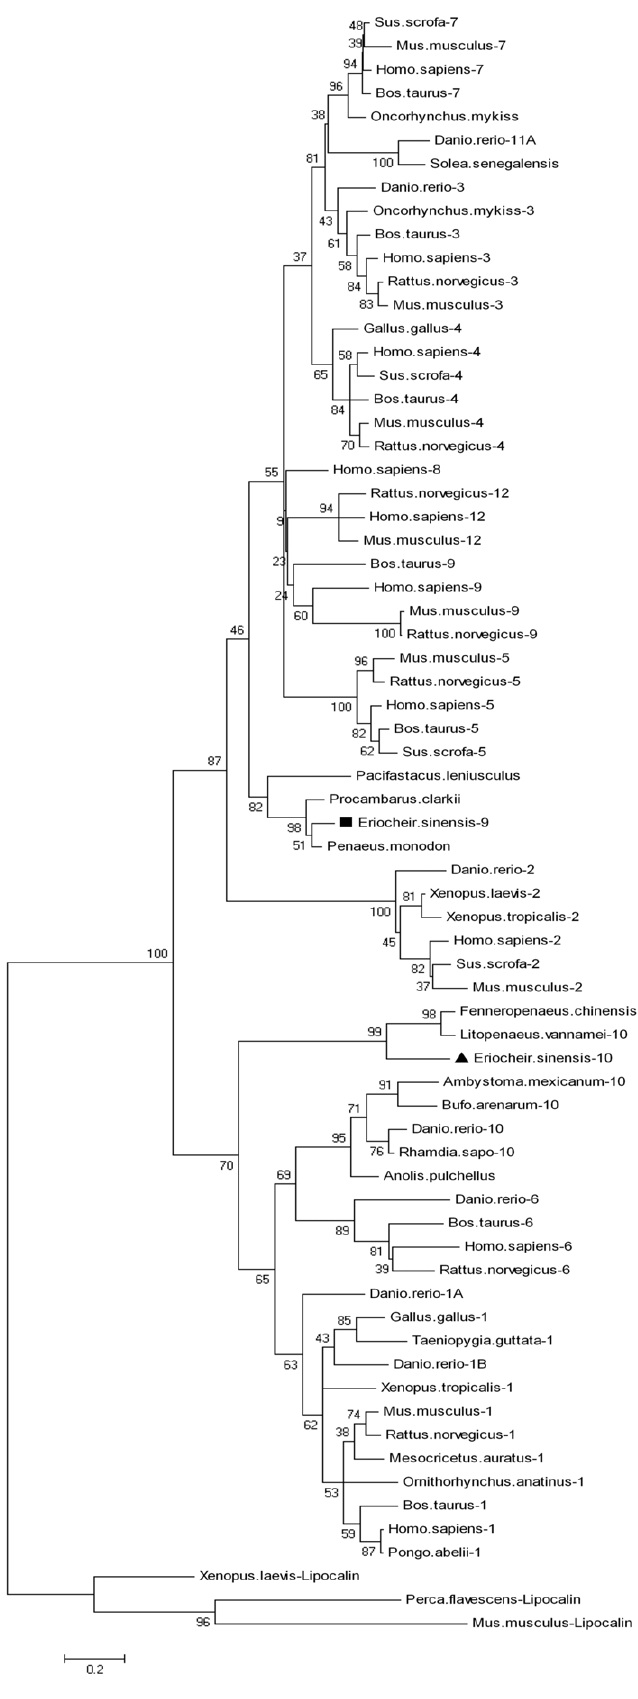
Figure 1. Phylogenetic analysis of Eriocheir.sinensis FABP with other known FABPs of sequences from GenBank. NJ tree